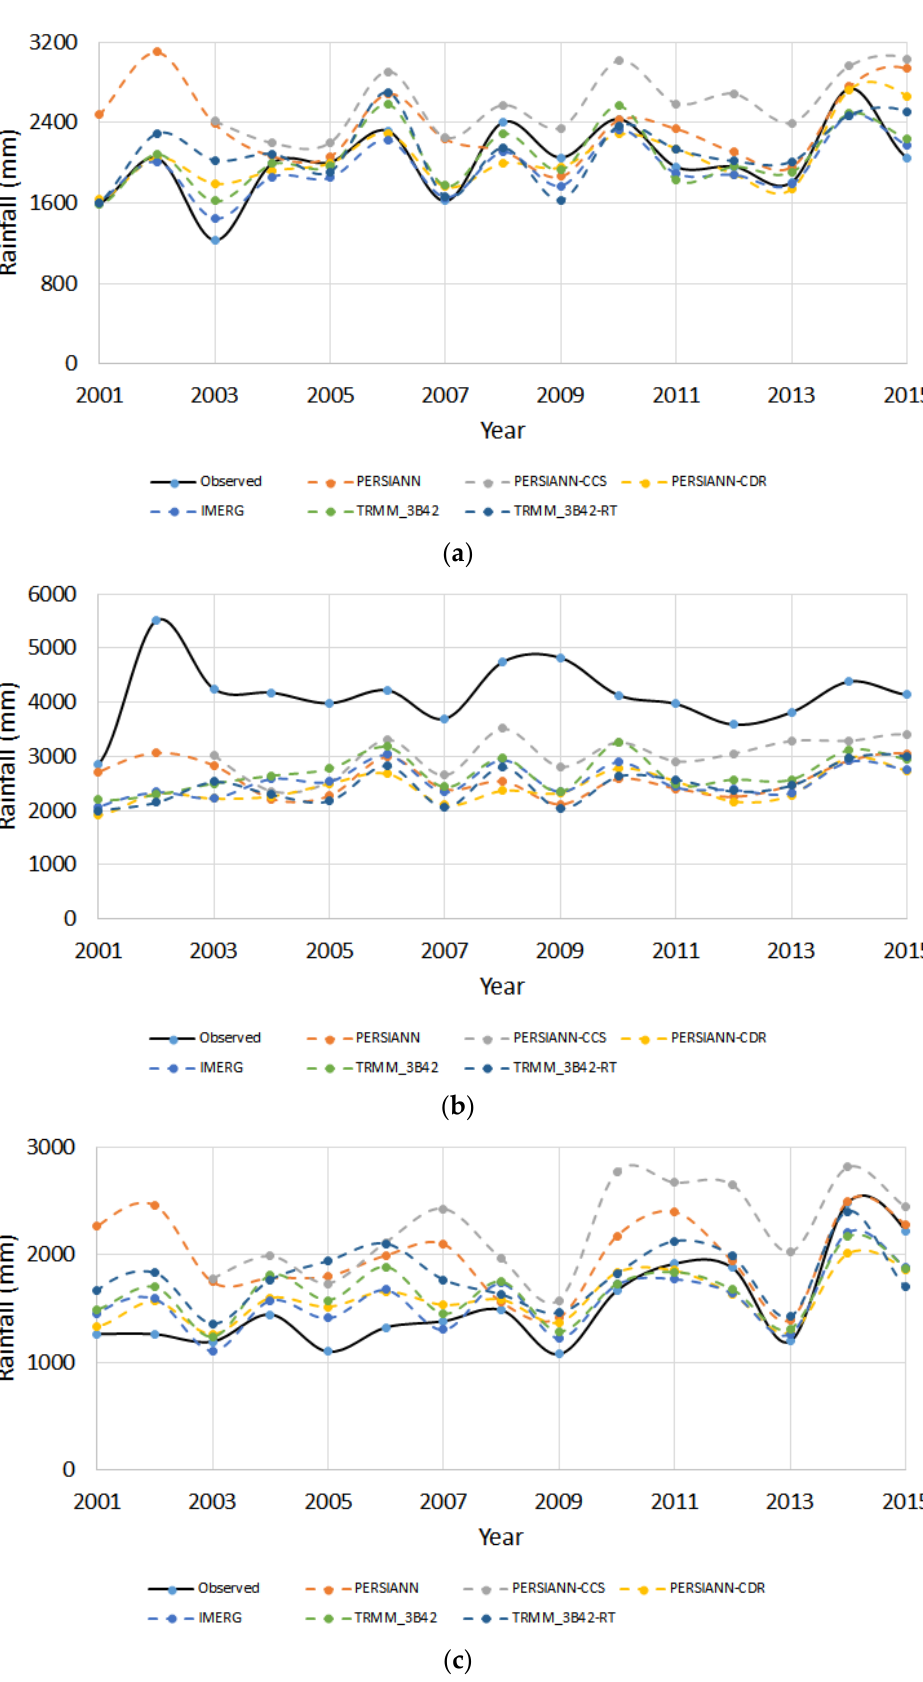
Figure 4. Elevation maps with rain gauges: ( a ) For Kurunegala; ( b ) For Eheliyagoda; ( c ) For Anura- dhapura.